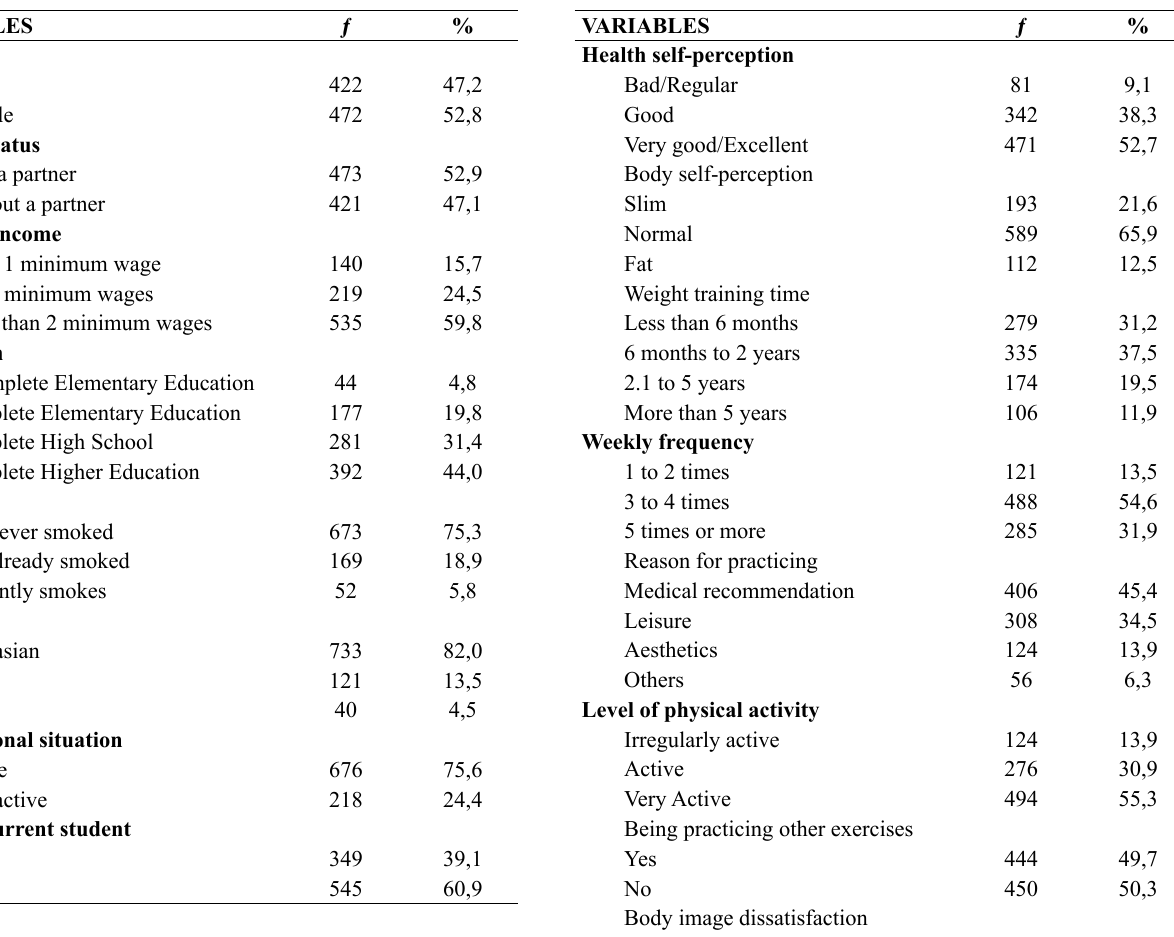
Table 2 . Profile of health and physical activity of weight training practitioners in Maringá, Paraná,